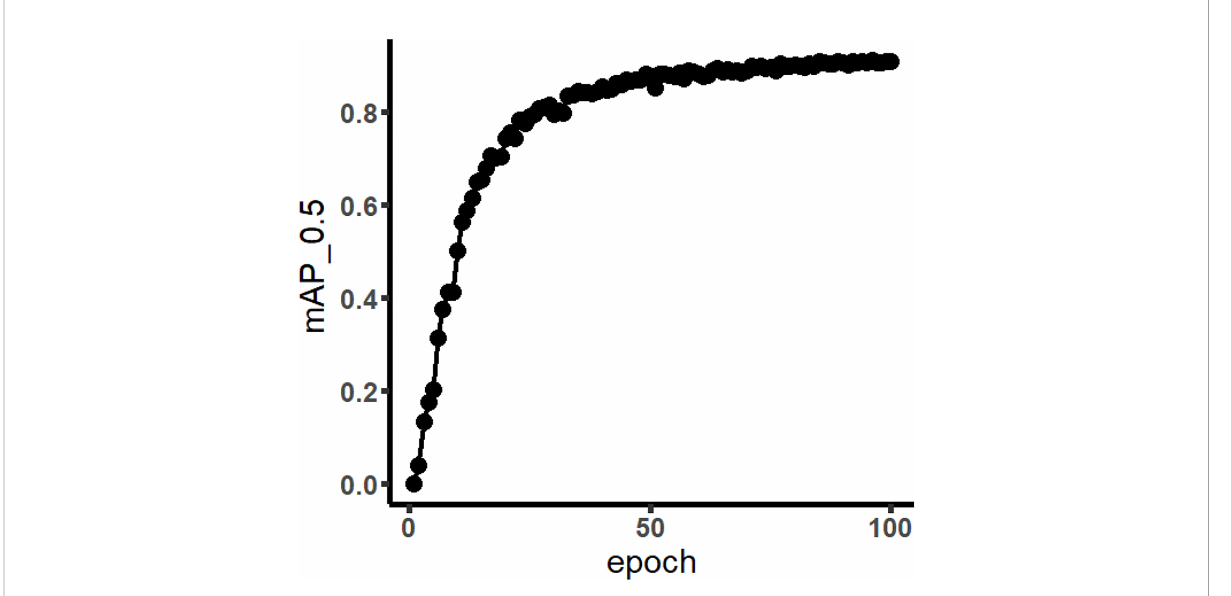
FIGURE 5 mAP curve of Faster R-CNN (the meaning of mAP_0.5 is that when IoU was set to 0.5, the average precision (AP) of all images in each category would be calculated. Then, the AP of all categories was calculated; that was